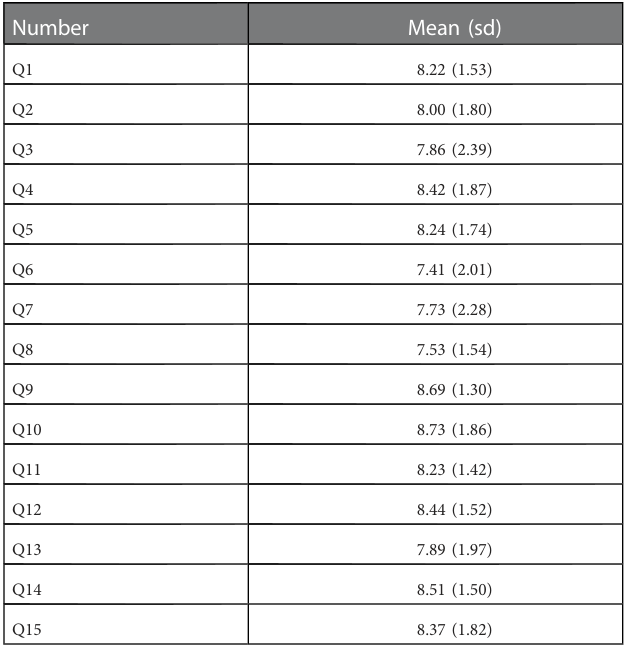
TABLE 2 Means and standard deviation of questions, score between 0 (very bad) and 10 (very good), see Table 1 for the de fi nition of questions, N =175.